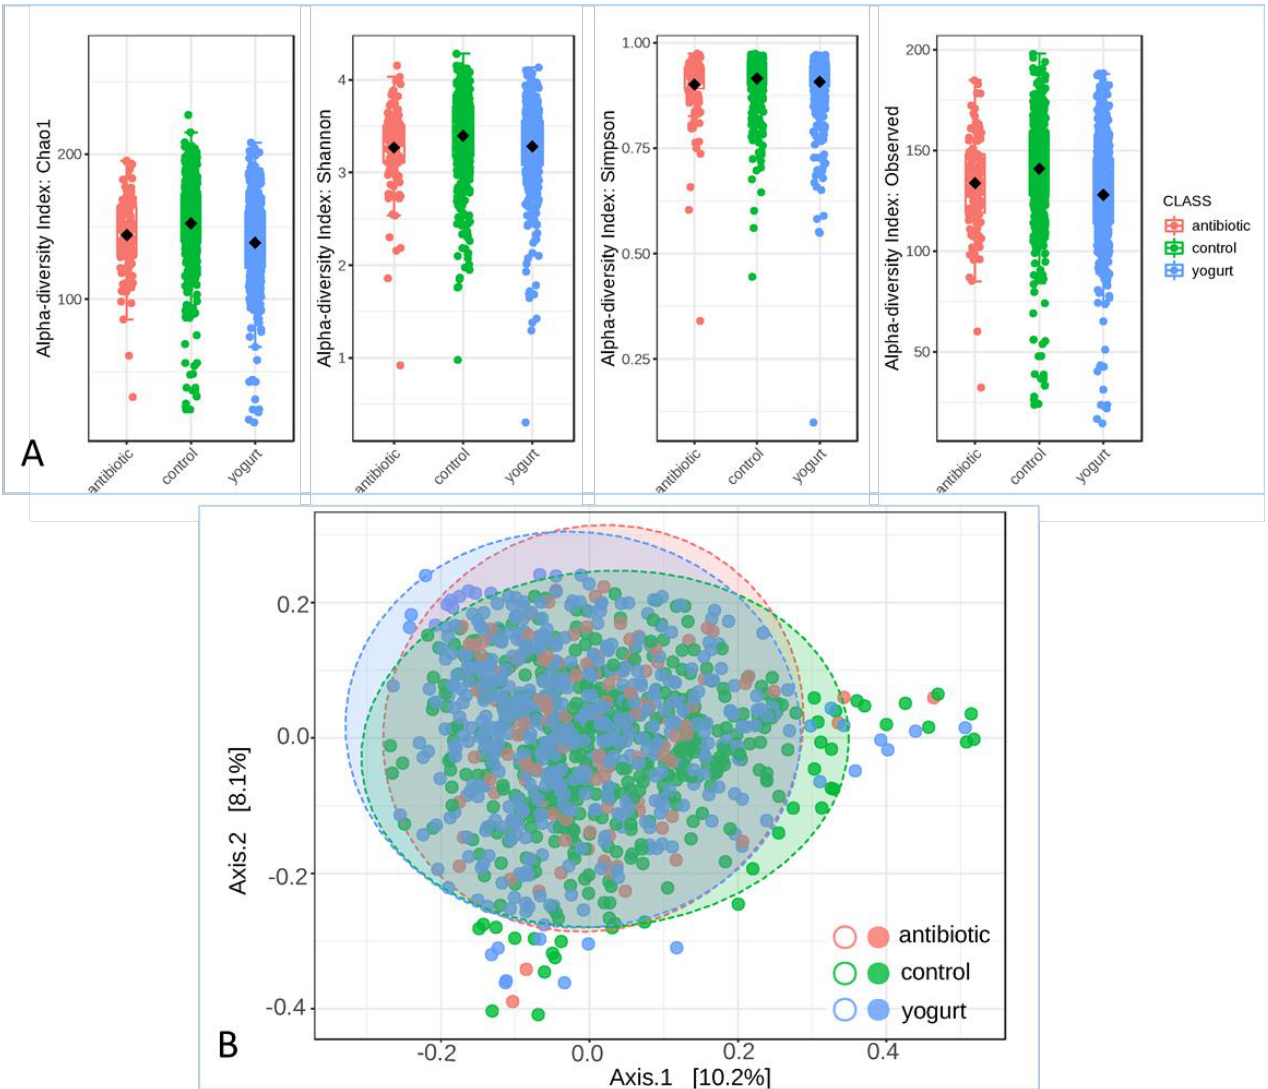
Figure 2. Alpha and Beta Diversity of the Gut Microbiome. ( A ) Alpha diversity evaluation at Chao1, Shannon, Simpson and observed indexes; ( B ) Beta diversity based on the PERMANOVA statistic